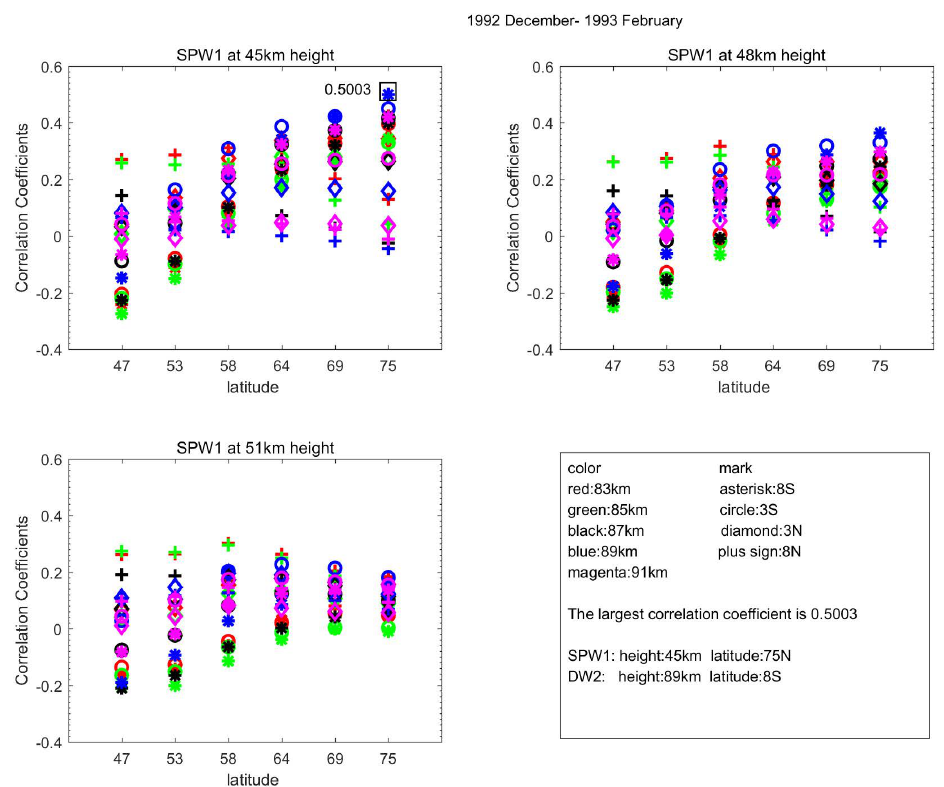
Figure 4. Correlation coefficients between SPW1 and DW2 at different combinations of latitudes and heights.